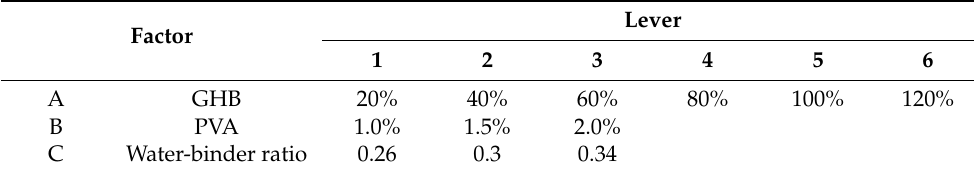
Table 3. Factor and level of the orthogonal experiments.